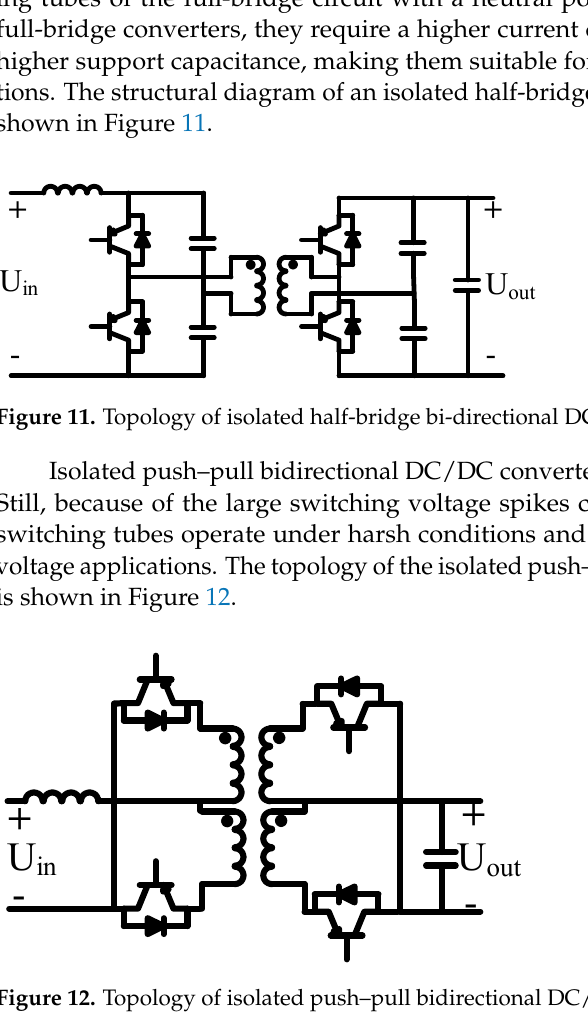
Figure 12. Topology of isolated push–pull bidirectional DC/DC converter. The isolated DC/DC converters have a low energy transfer efficiency due to the pres- ence of isolated devices, which can be improved by improving the structure of the isolated devices to achieve soft switching. In addition, isolated converters face problems such as component parameter degradation and resonance. However, for high-power energy stor- age in the rail transit sector, isolated DC/DC converters are an essential part of the energy storage system.